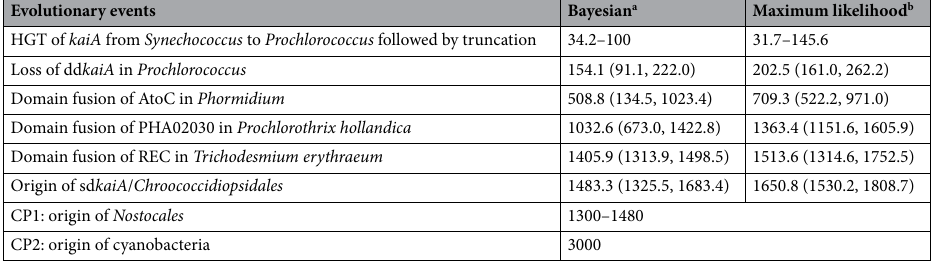
Table 3. Bayesian and maximum-likelihood time estimates for the events in the evolution of the kaiA homologs based on the species trees (Mya). a Posterior mean (95% HPD). b Mean (95%